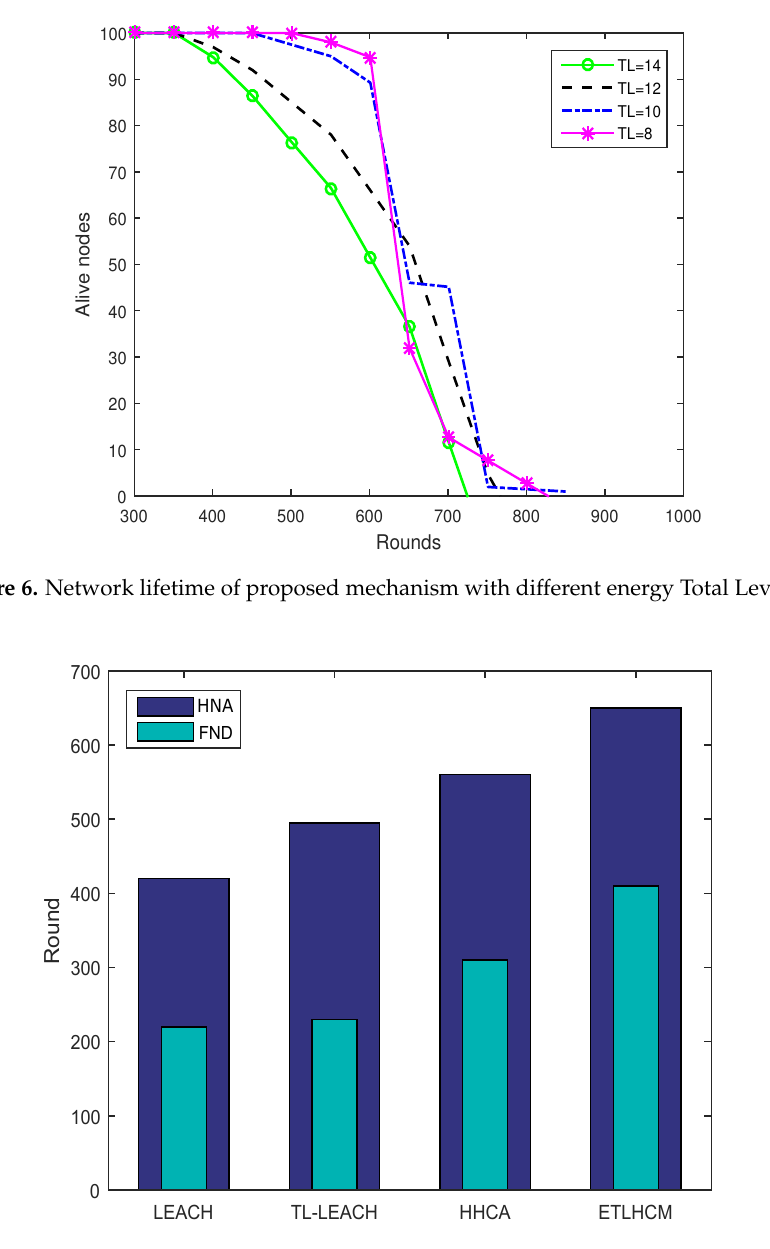
Figure 7. Network lifetime based on First Node Dies (FND) and Half of the Nodes Alive